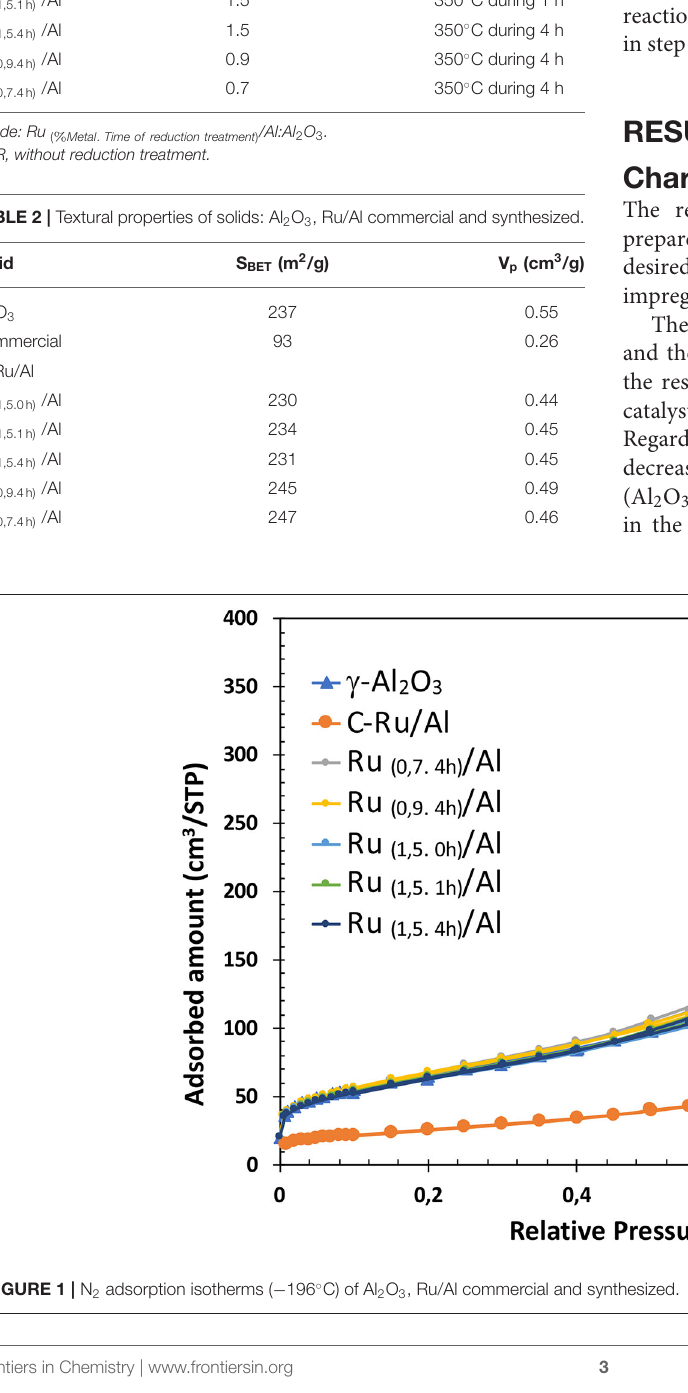
Frontiers in Chemistry |